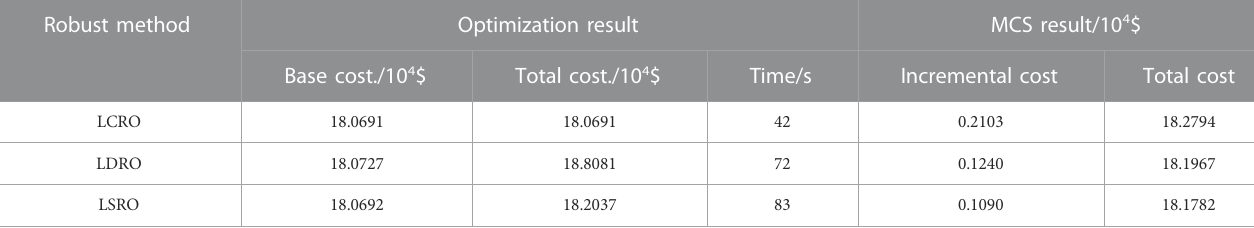
TABLE 7 Comparison of robust methods in the IEEE 118-node system. Robust